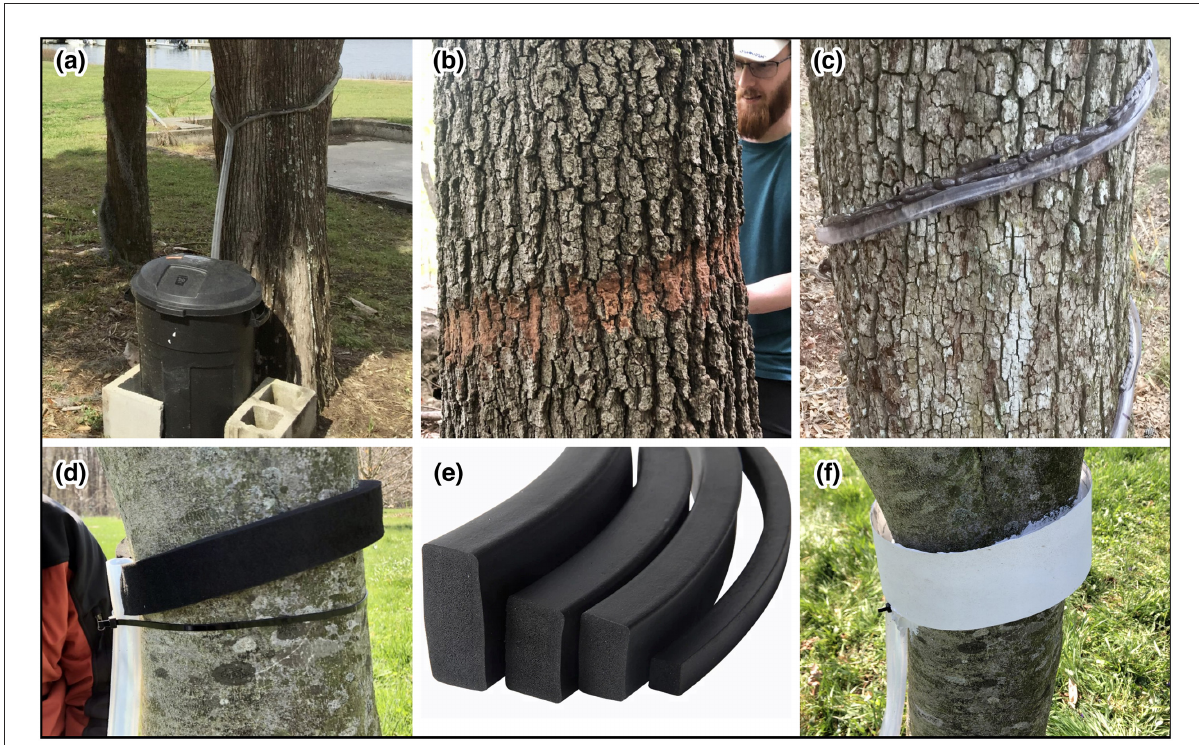
FIGURE2 Stemflow may be captured for sampling in many ways. Generally, (a) stemflow is diverted from the bark surface by a collar that drains via gravity to a collection bin. (b) Where bark is thick, the outer bark may require trimming prior to installing a collar. (c) Stemflow collar materials often consist of flexible tubing, cut length-wise, wrapped around the stem, then nailed in place and sealed. (d) To avoid using nails, adhesive-backed foam tape may be used as a collar base, (e) which comes in a variety of widths to accommodate differing bark thicknesses, (f) and a wall of flexible plastic may be used to help direct stemflow to the drainage